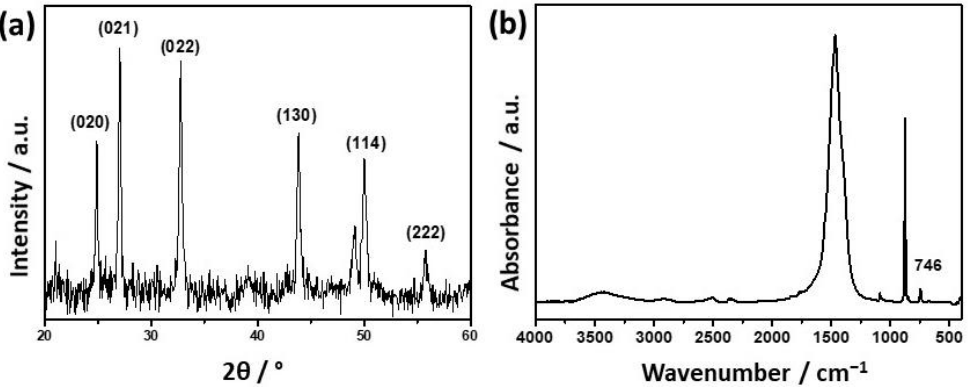
Figure 6. ( a ) PXRD pattern and ( b ) FTIR spectrum of precipitate, predominantly vaterite, isolated after 10 min of aging in the control system: c i (Ca) = c i (CO 3 ) = 20 mmol dm – 3 ; pH i = 8.15; ϑ /°C = 25 ± 0.1.